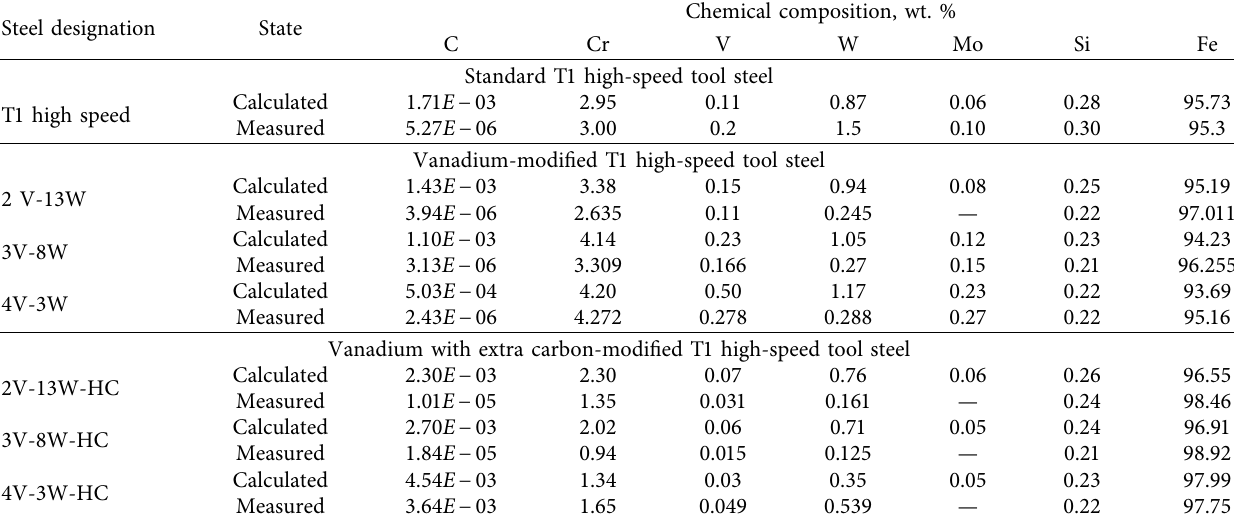
Table 8: Chemical composition of the matrix for T1 high-speed tool steel and its diferent variants (as solidifed). Steel